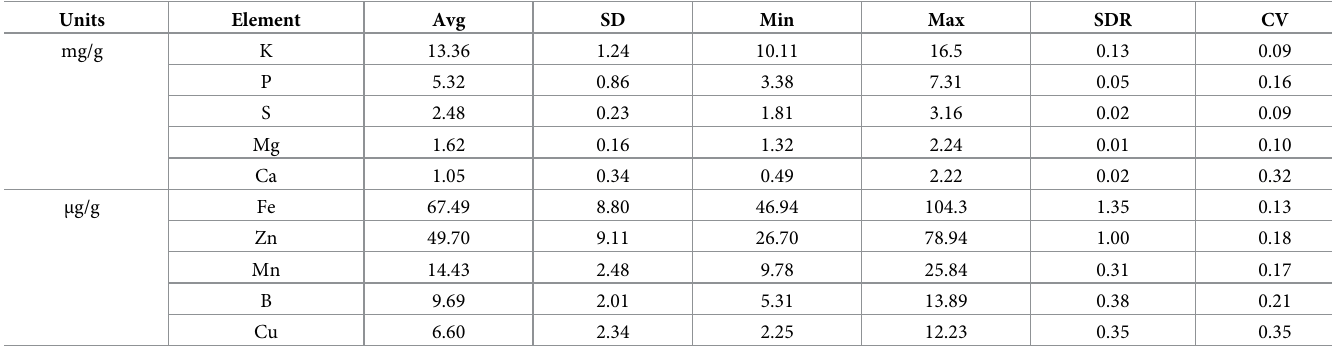
Table 1. Descriptive statistics of seed mineral concentrations of 96 diverse pea accessions. Units